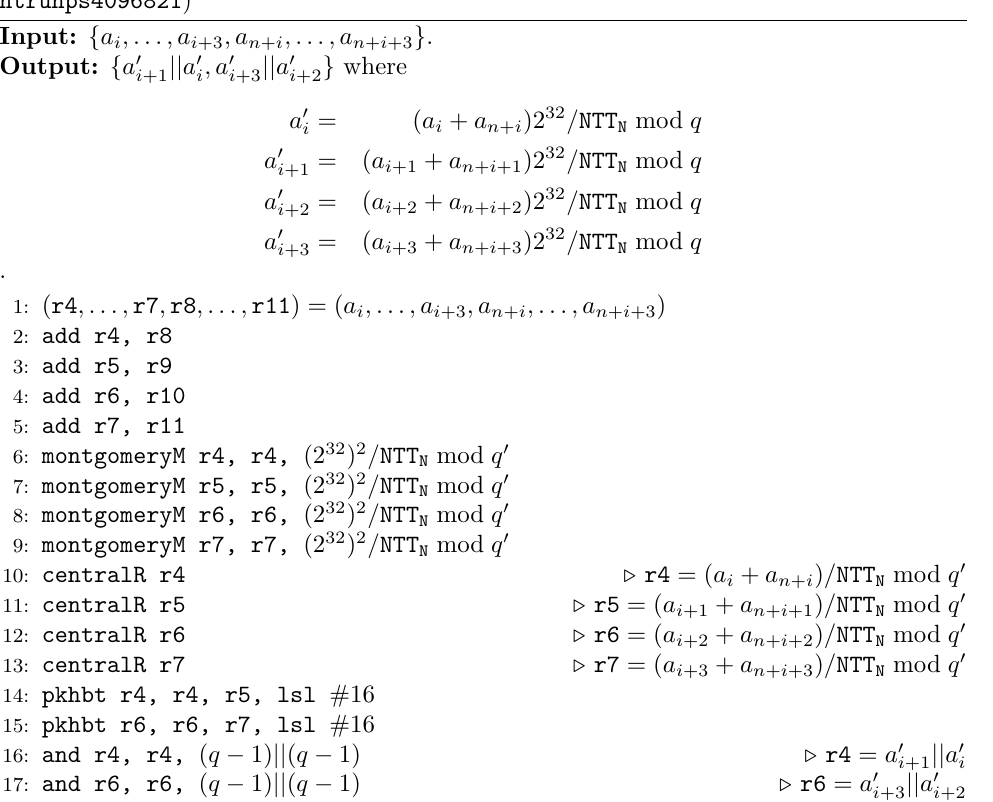
Algorithm 20 NTRU central reduction loop(for ntruhps2048677 , ntruhrss701 , and ntruhps4096821